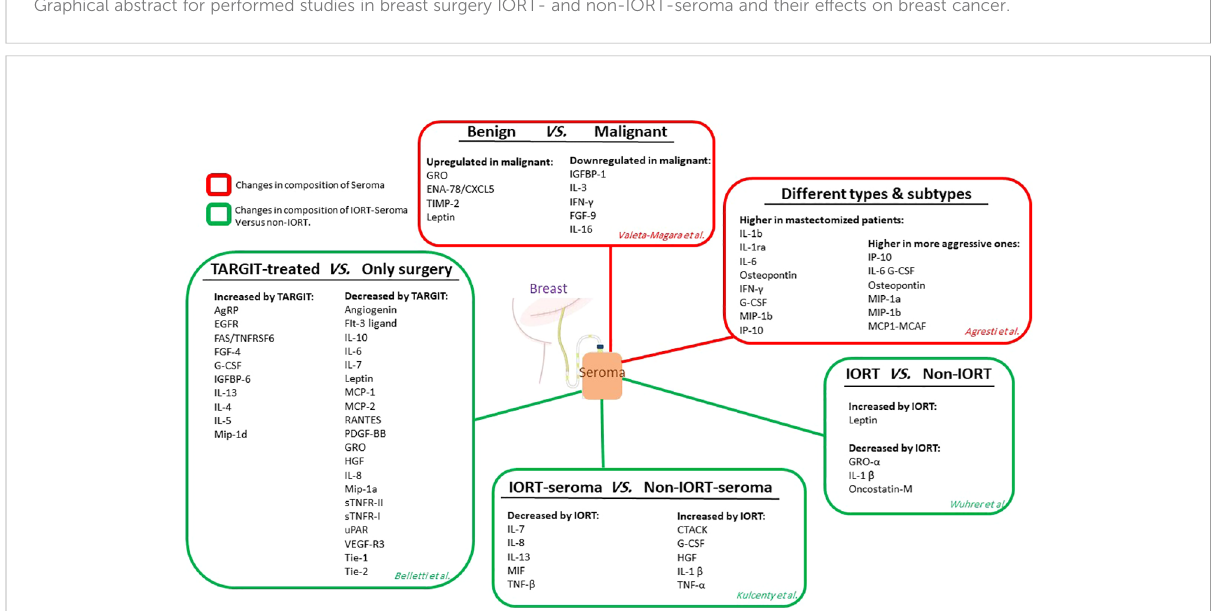
FIGURE 4 The studies related to seroma composition. Red boxes show the level of protein expression in seroma without considering radiotherapy. Green boxes show protein expression levels in an IORT-affected seroma compared to non-IORT-affected